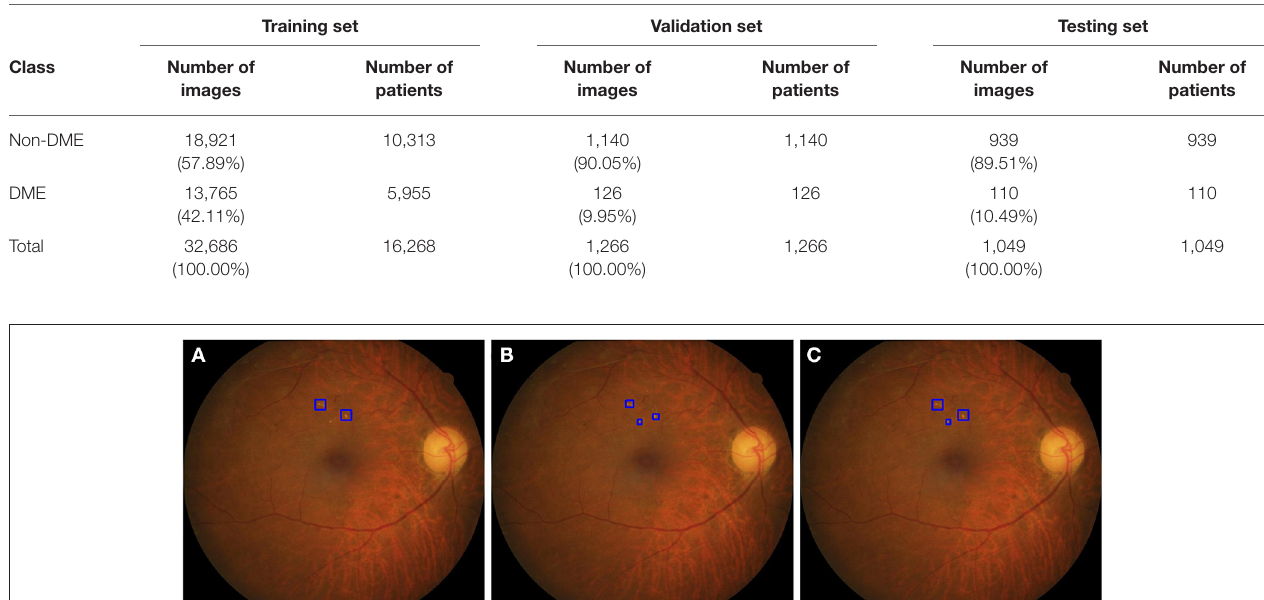
images were released, the requirement for signed